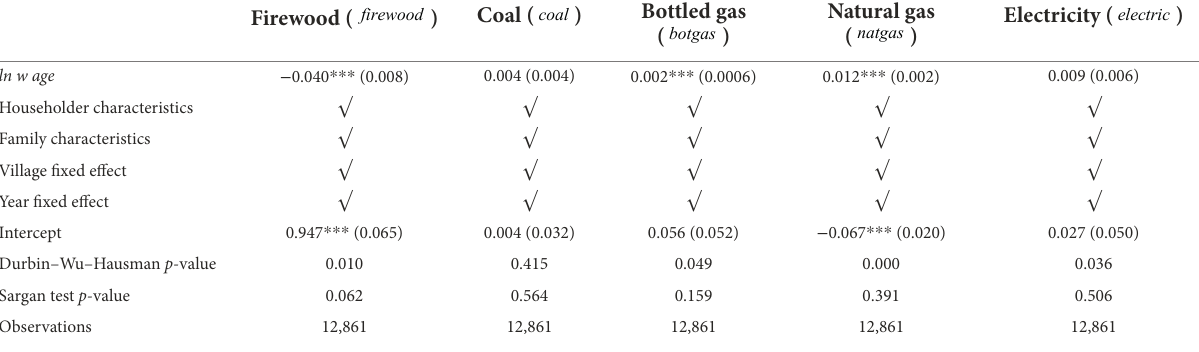
TABLE 8 Robustness test by wage